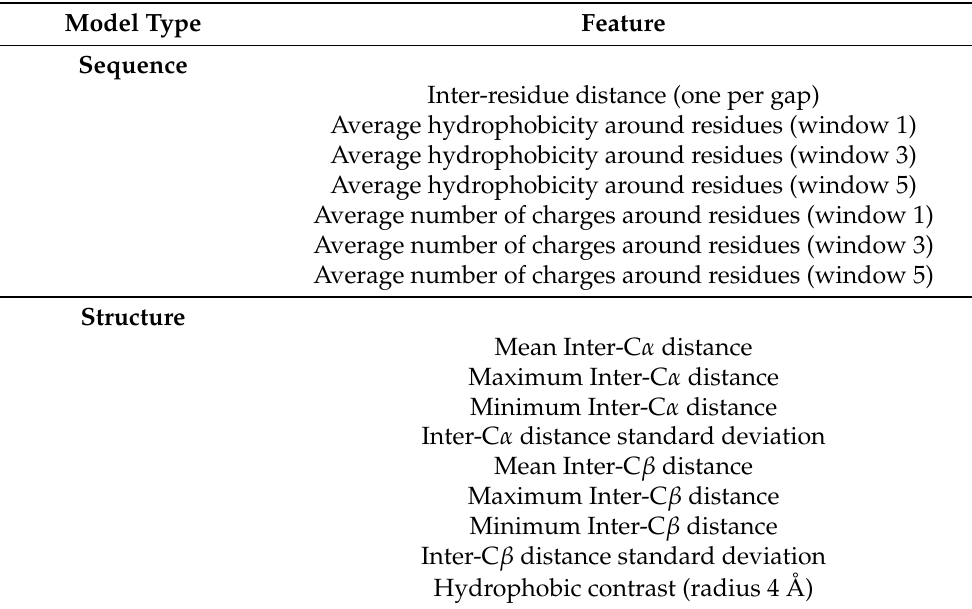
Table 5. Details of how features are calculated for residue combinations in structure and sequence models. Hydrophobicity of sequence residues is defined using Wimley and White’s scale [26], charge is the count of charged residues (aspartate, glutamate, arginine, histidine and